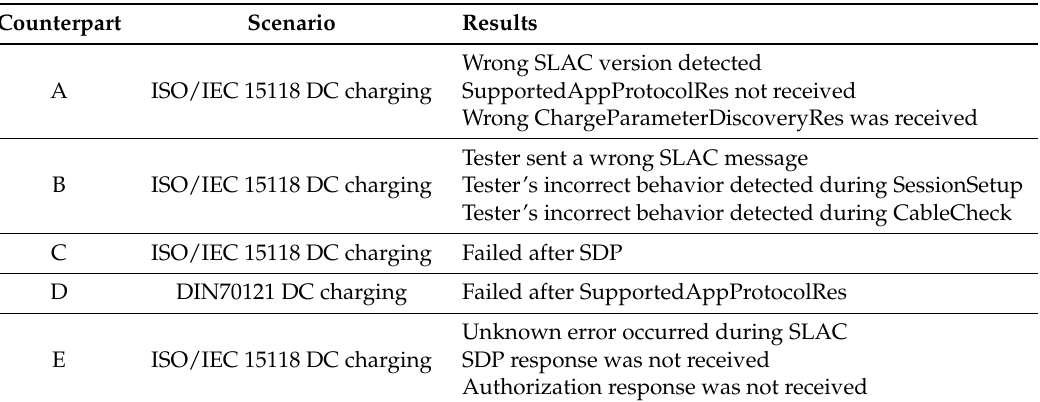
Table 4. Test results at the Chicago test event.